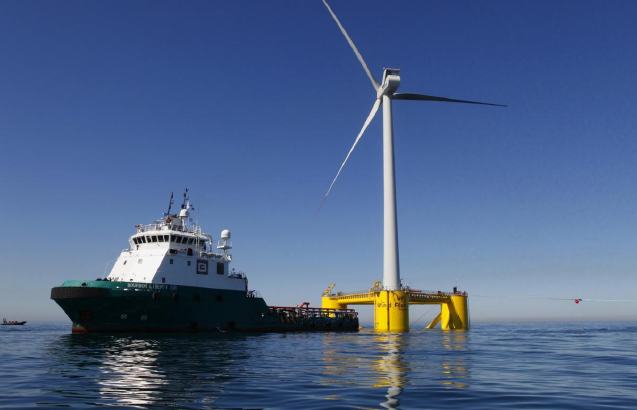
Figure 1. Maneuver of installation of the Windfloat device towed by a